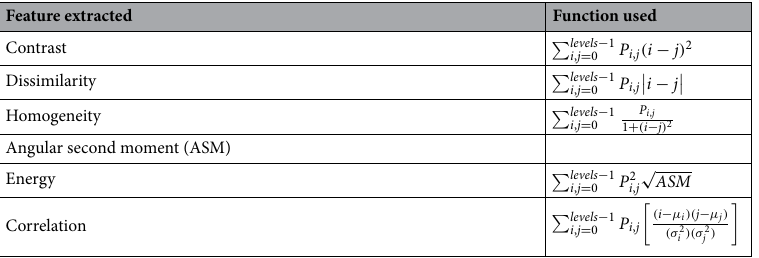
Table 4. GLCM Texture features extracted from image analysis. Where P[i,j,d,theta] is an 4-D ndarray grey level co-occurence matrix and represents a histogram of co-occuring greyscale values at a given offset over an image. The P value represents a matrix with value number of times that grey-level j occurs at a distance d and at an angle theta from grey-level i. The syntax for function greycomatrix, P[i,j,d,theta] is given below. The default values were used for these parameters. P[i,j,d,theta] = skimage.feature.texture. greycomatrix(image, distances, angles, levels = 256, symmetric = false, normed = false).